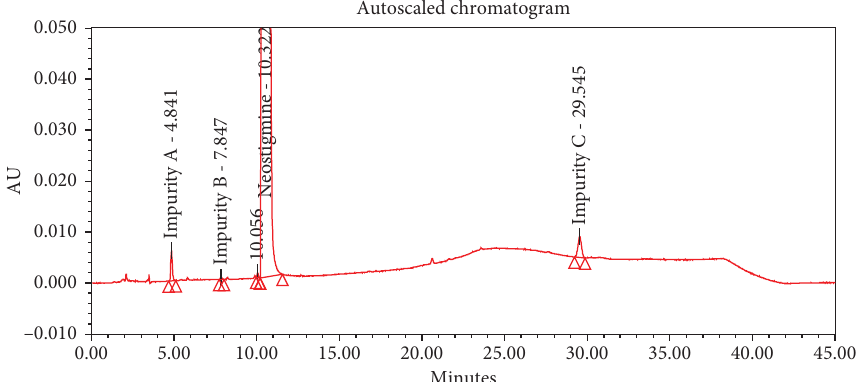
Figure 1: Chromatogram of neostigmine methylsulfate working standard spiked with all known impurities.